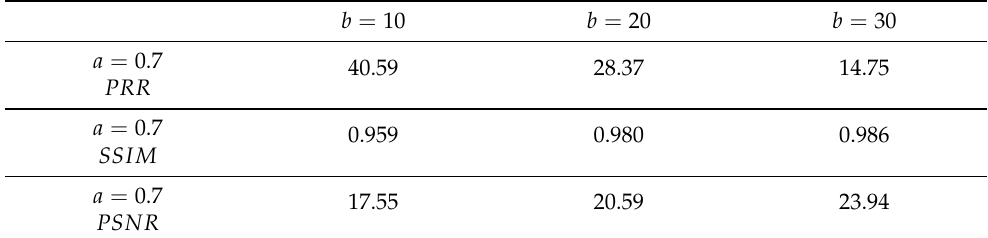
Table 3. Lena image without HE for a = 0.7.